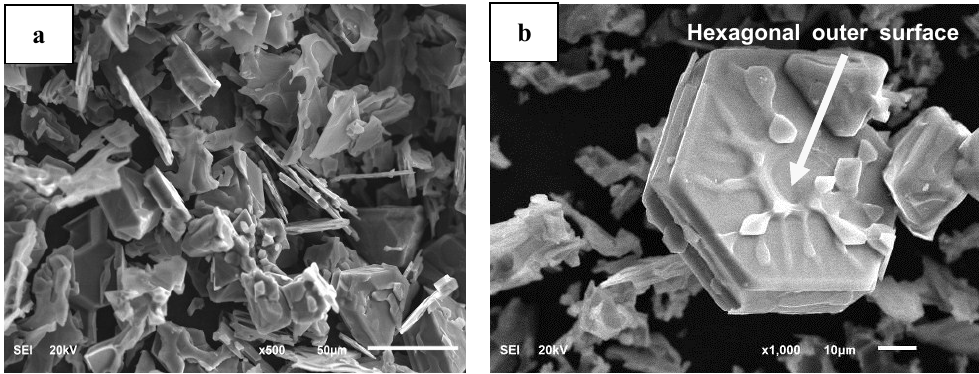
Figure 9. Morphology of primary Si in unmodified Al-17%Si